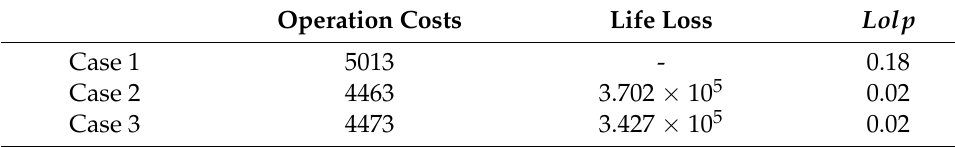
Table 3. Comparison of results for different optimization objectives.